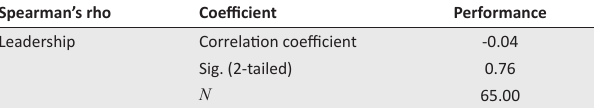
TABLE 9: Correlation analysis between Perceived Leadership Styles and Individual Job Performance. Spearman’s rho Leadership